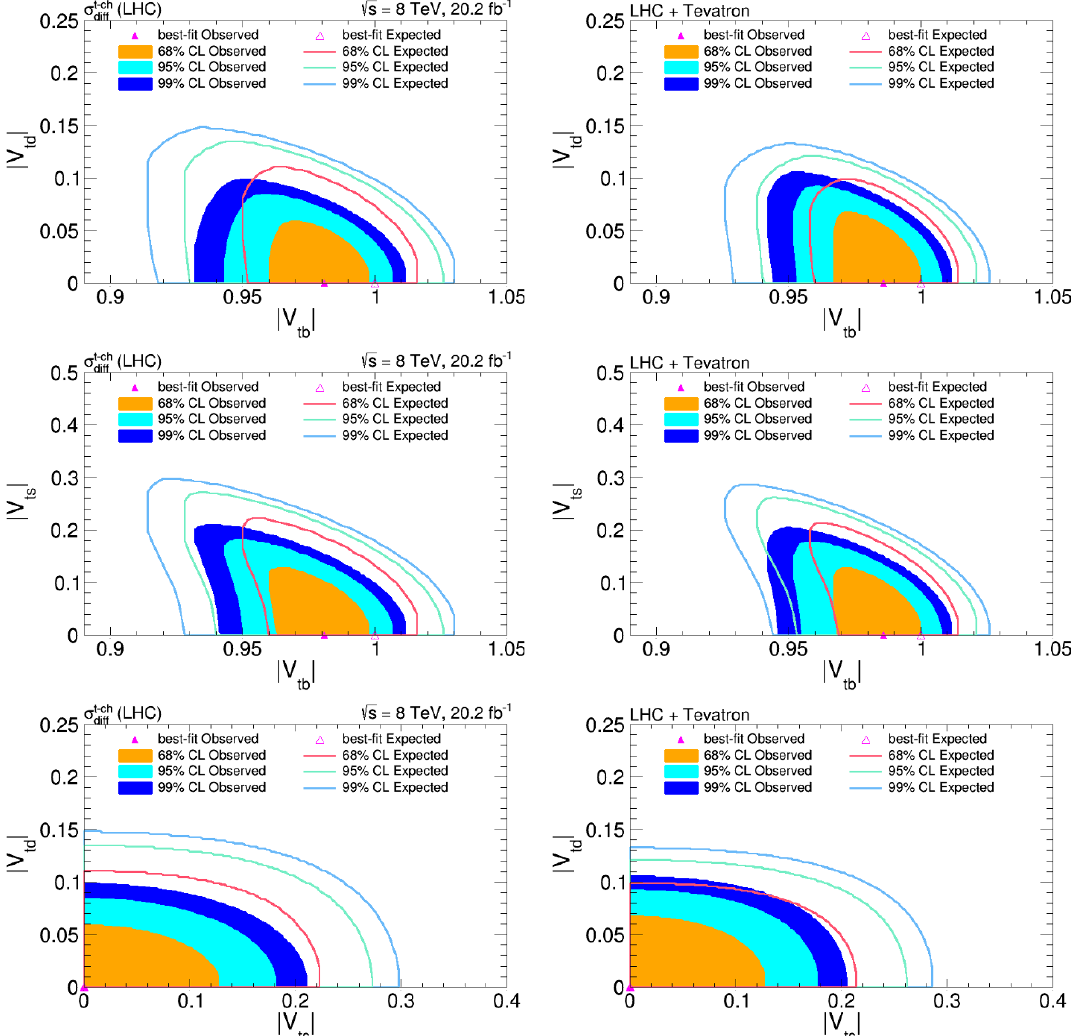
Figure 6 . The expected and observed best (cid:12)t values together with the expected and observed 68%, 95% and 99% con(cid:12)dence level regions in the ( j V td j , j V ts j ), ( j V tb j , j V ts j ) and ( j V td j , j V tb j ) planes from single top t -channel di(cid:11)erential cross section measurements at 8 TeV by the ATLAS Collab- oration [22] in the left column and from the combination of all LHC and Tevatron measurements (see table 1) in the right